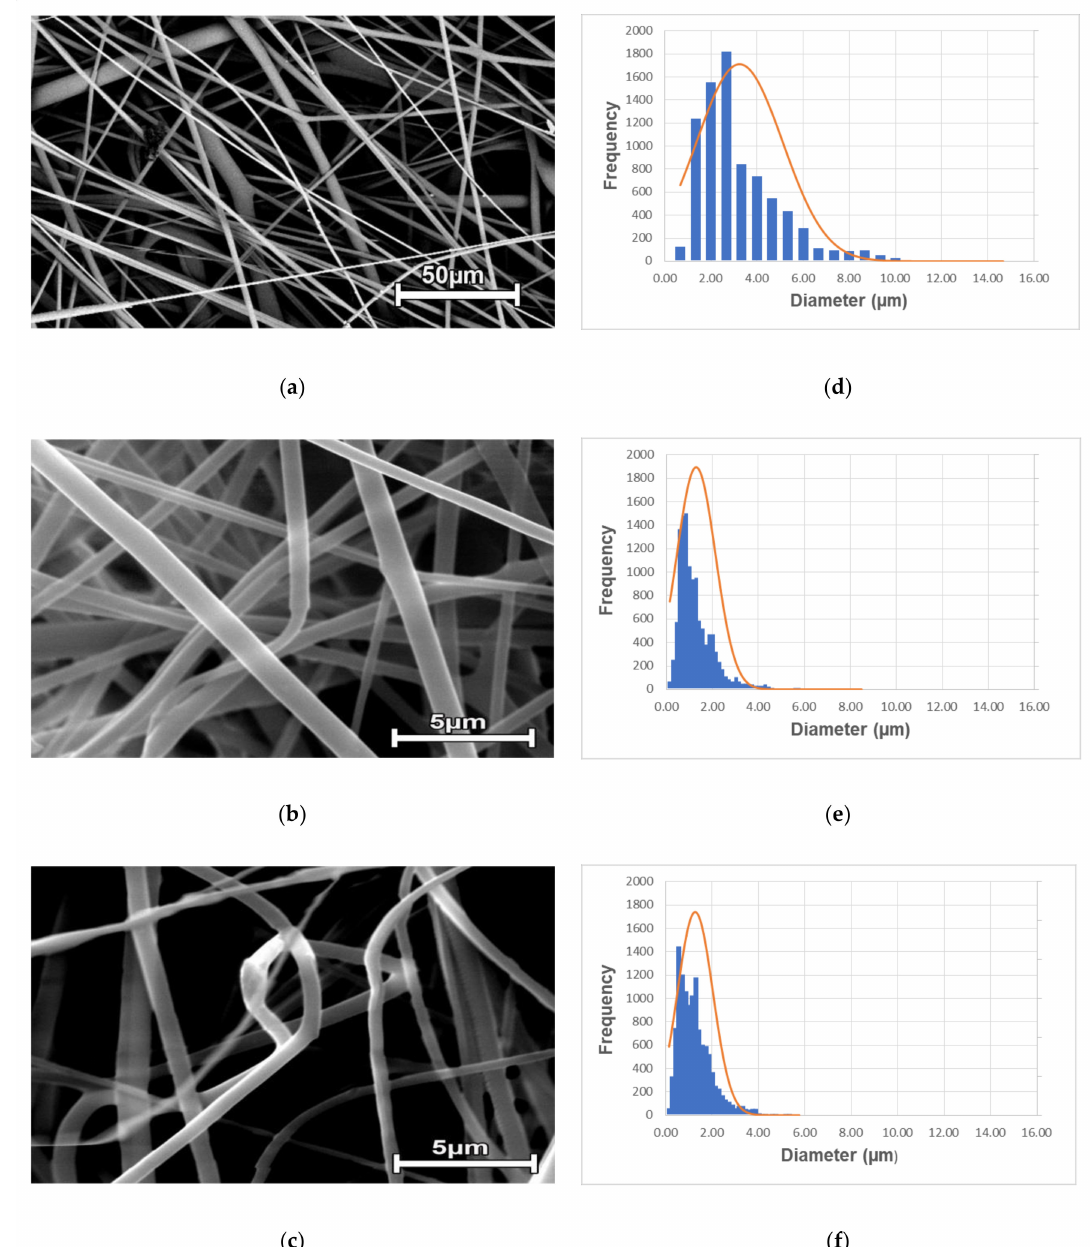
Figure 1. SEM images of electrospun recycled PET fibers: PET20_0.8 ( a ); PET12_0.8 ( b ) and PET12_1.0 ( c ), with their respective fiber size distribution ( d – f